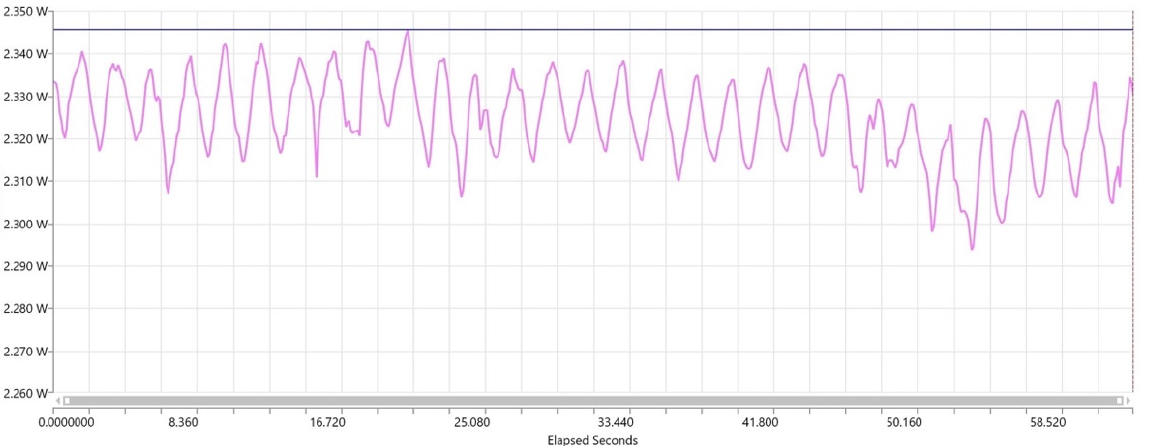
Figure 2. Representative power output of the SIROLaser Blue (970 nm) in continuous-wave mode over 60 s.